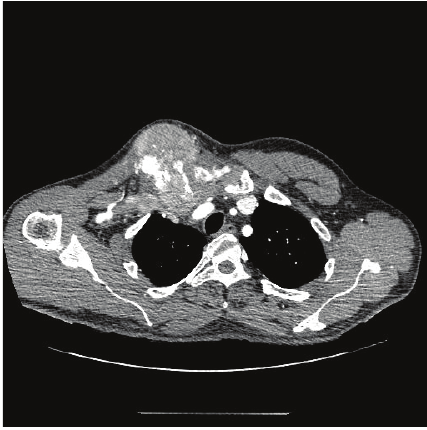
F 2: Axial CT section with mass on the medial side of the clavicle.